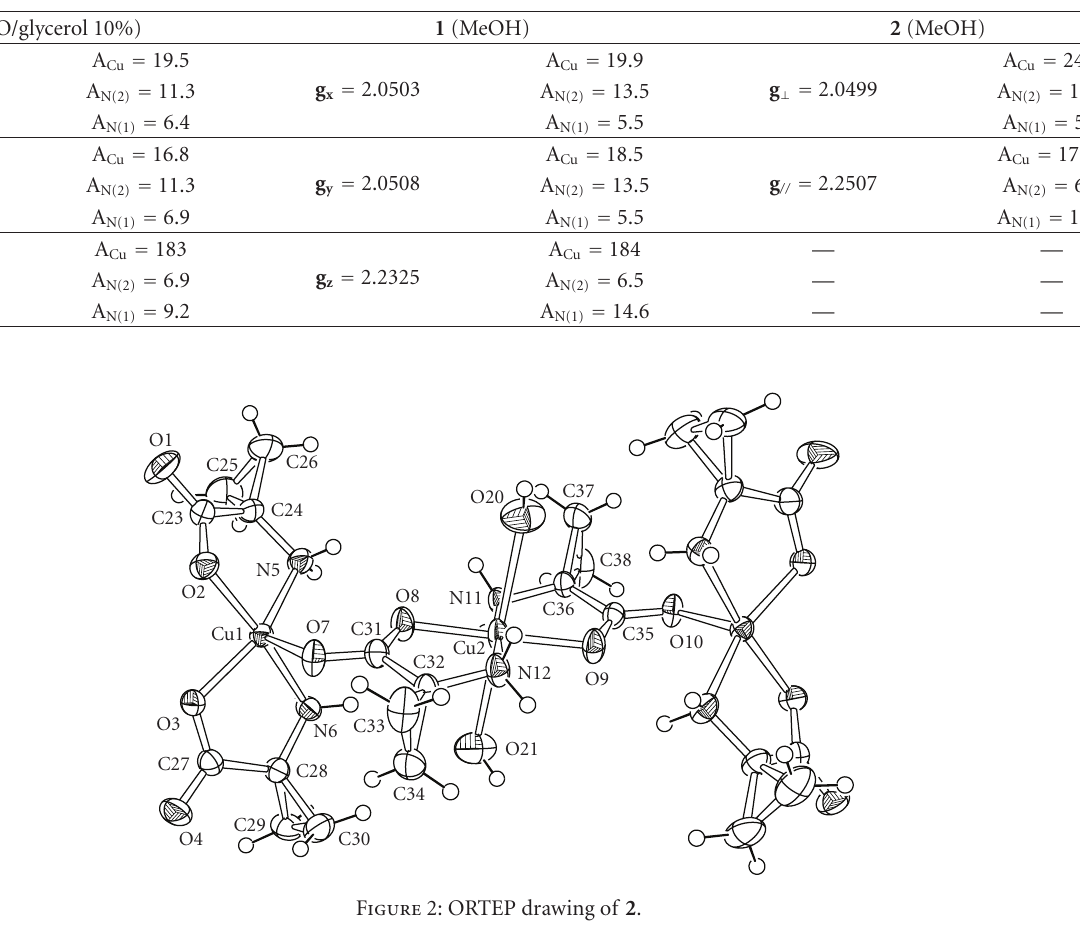
Table 3: EPR constants for 1 and 2 in MeOH or in water/glycerol obtained from the simulation. Coupling constants are expressed in 10 − 4 T. The contribution of naturally abundant 63 Cu and 65 Cu is considered, but here the values refer to 63 Cu.